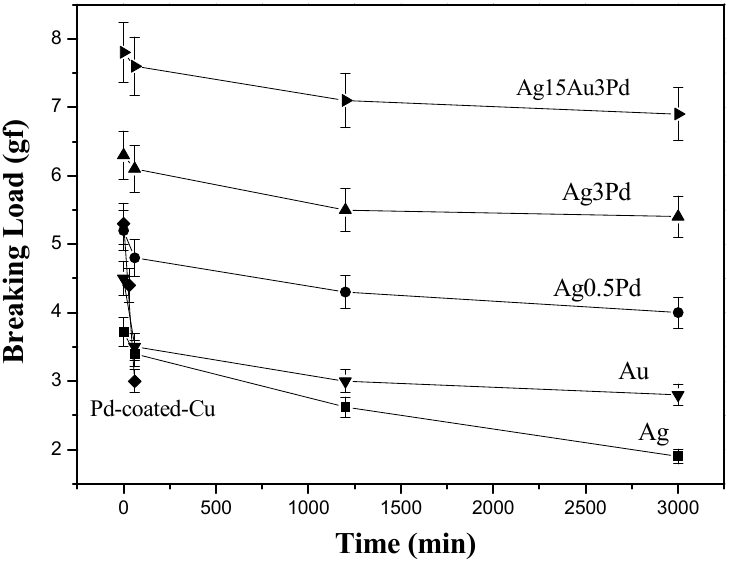
Figure 11. Variations in the breaking loads of bonding wires after current stressing at 1.23 × 10 5 A/cm 2 for various times.